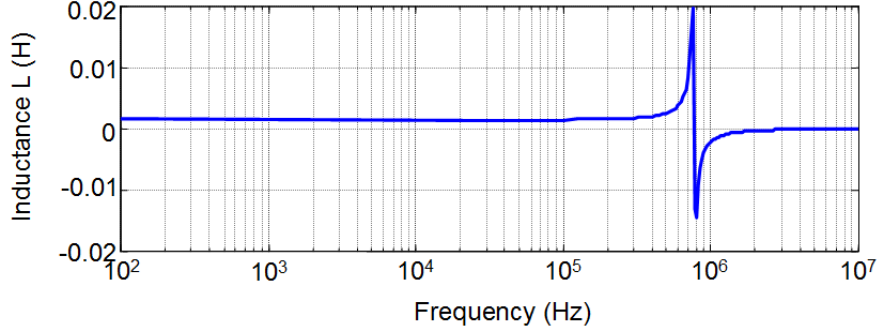
Figure 14. Inductance measurements as a function of frequency for a 28-turn E47/20/16 ferrite